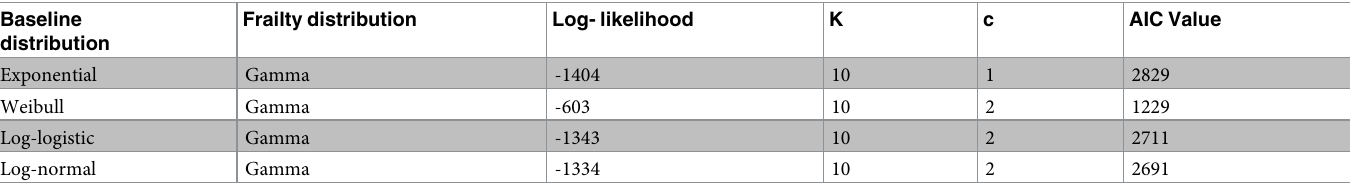
Table 2. Comparison of fitness of different parametric frailty models based on the Akaike information criteria, June 2018. Baseline